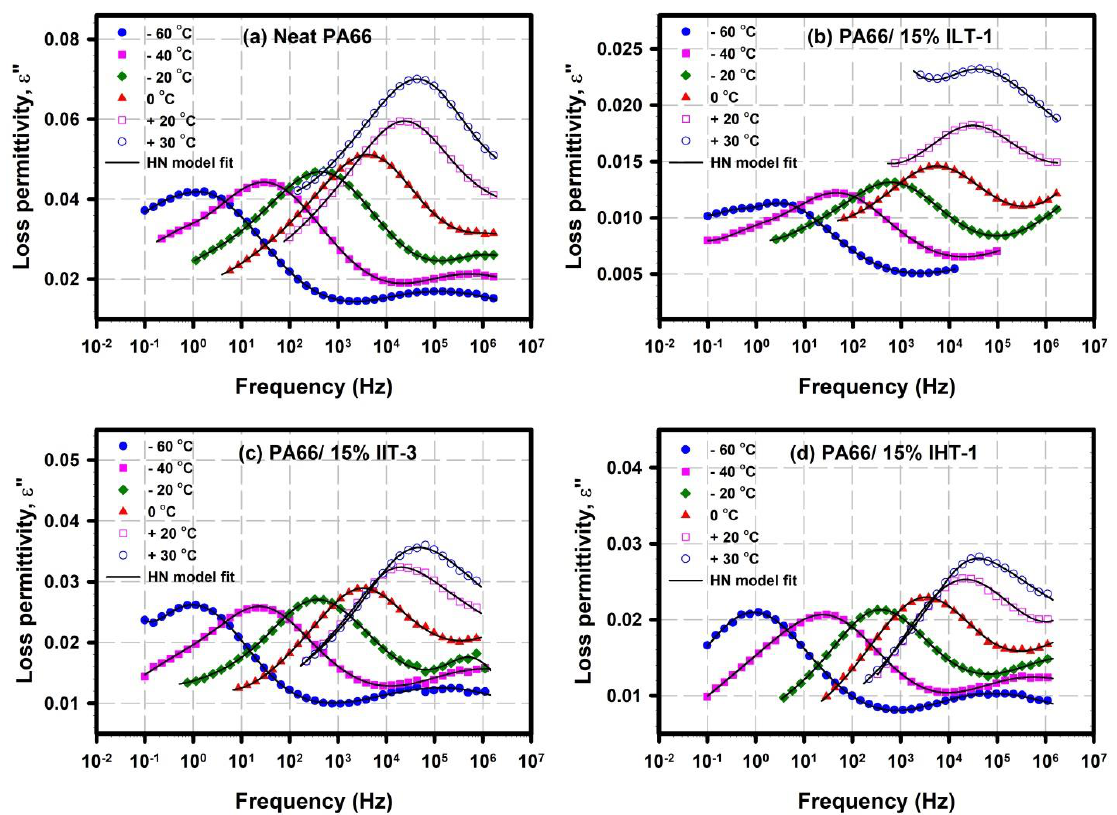
Figure 5. ε ″ vs. f spectra at different temperatures for the studied PA66/P-glass systems and processed virgin PA66 showing the γ relaxation. Lines show the Havriliak–Negami (HN) equation fits to the spectra.